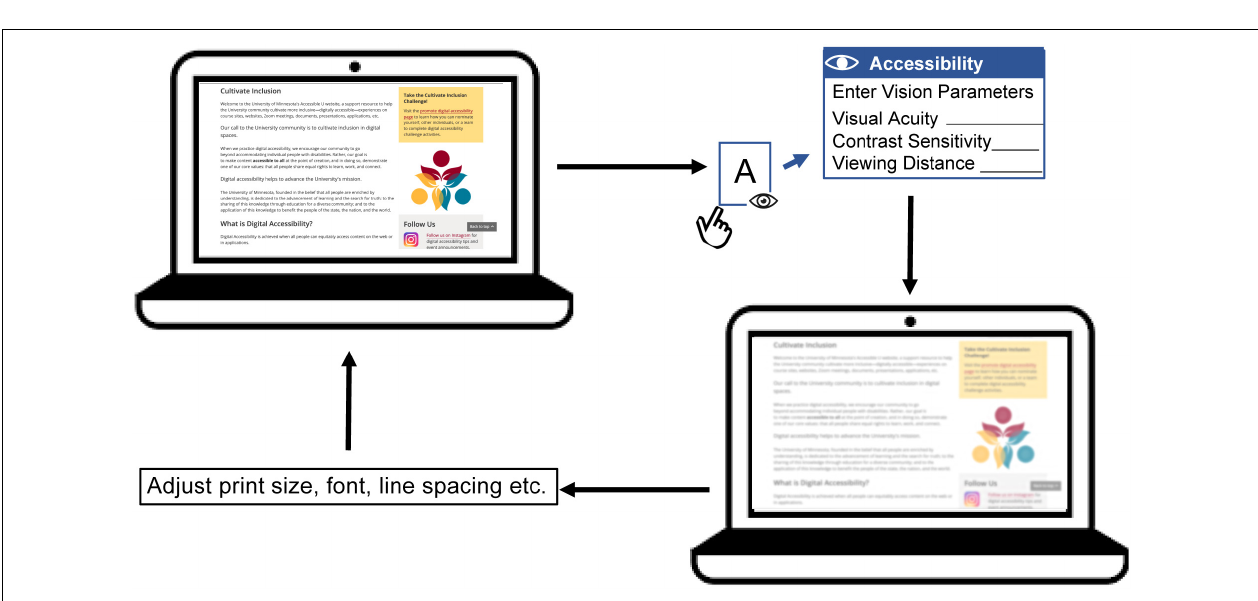
FIGURE 6 | A flowchart illustrating the conceptual design of an accessibility checker for web pages. A web page with text, pictures and links is presented on a laptop screen. The accessibility checker functions as a plug-in for the web browser, which can be initiated by the user. Once initiated, the accessibility checker requests user input including acuity, contrast sensitivity (if available) and preferred viewing distance. The accessibility checker then transforms the web page to demonstrate visibility for the corresponding low-vision condition. This simulation will show an eye-care clinician, family member or web designer how visible the web content is expected to be for the person with low vision. Lastly, the user can adjust the display properties such as overall zoom or print size, font, line spacing etc. to make the page more accessible. The user can repeat this process until the web page appears accessible under the corresponding low vision